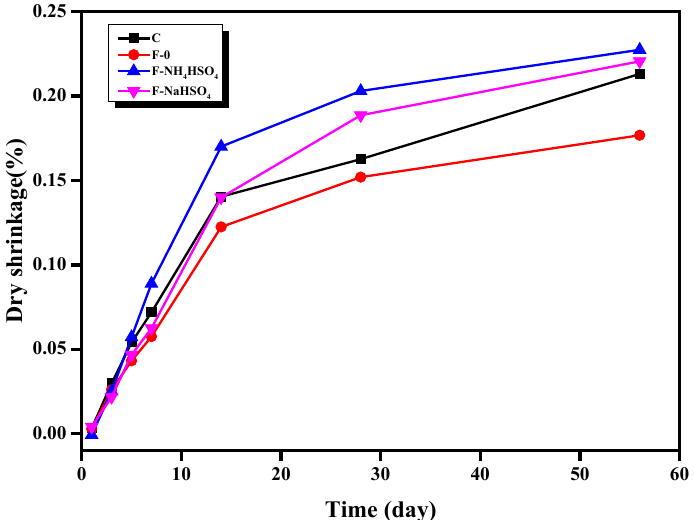
Figure 4. Effect of different sulfates on the drying shrinkage of fly ash cement paste.